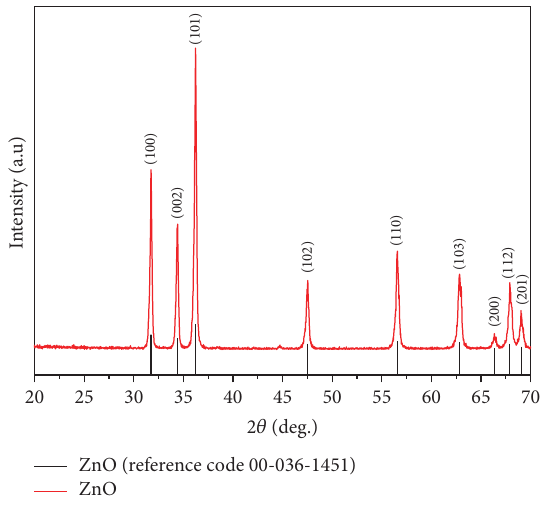
Figure 2: XRD patterns of ZnO nanostructures.